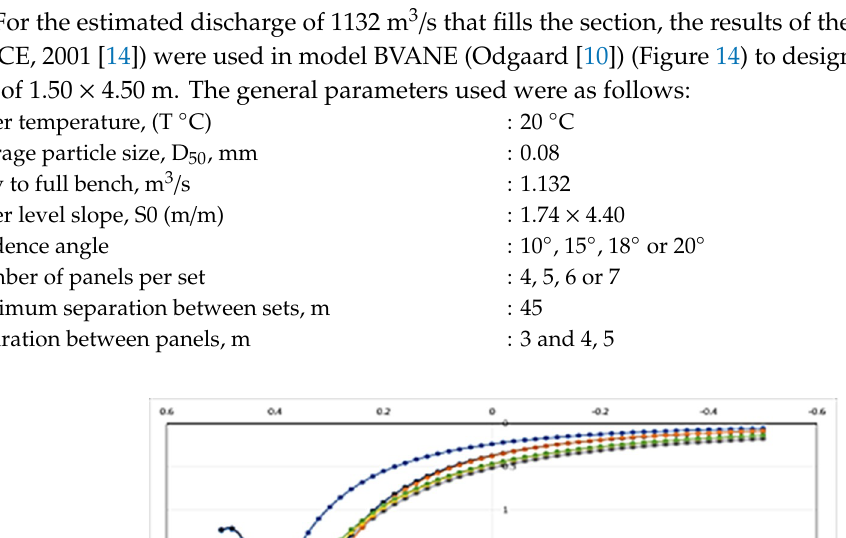
Figure 13. Rio Metica, Puerto López: the two spurs that remain, although highly deteriorated, of the six previously built.